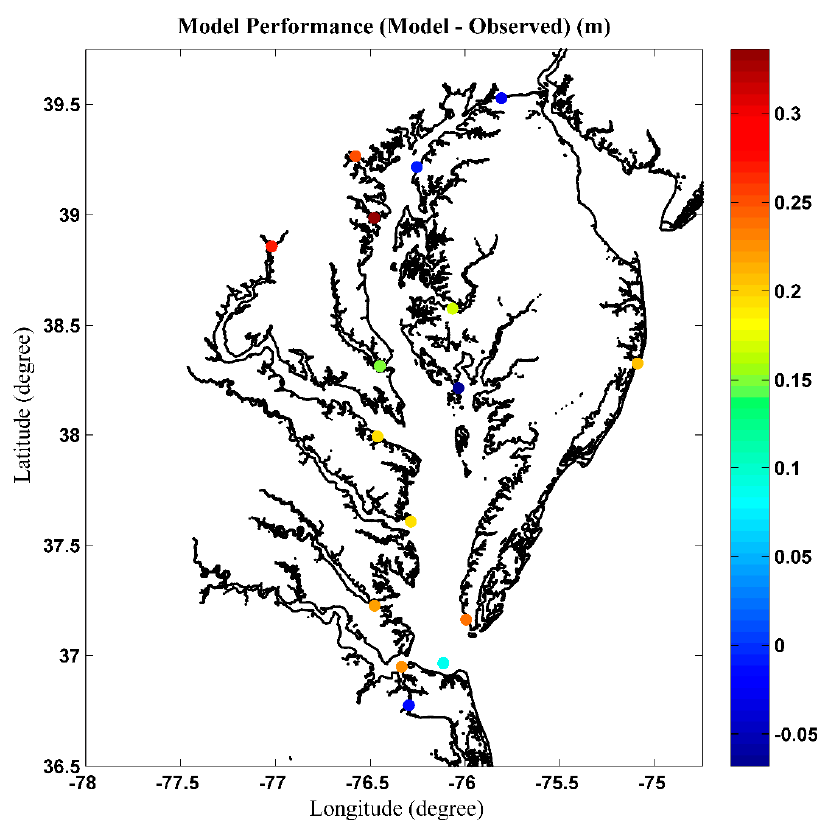
Figure A1. Model validation for Irene showing the error in maximum water level. Table A1. Frictional parameter values applied in the storm surge and waves model.